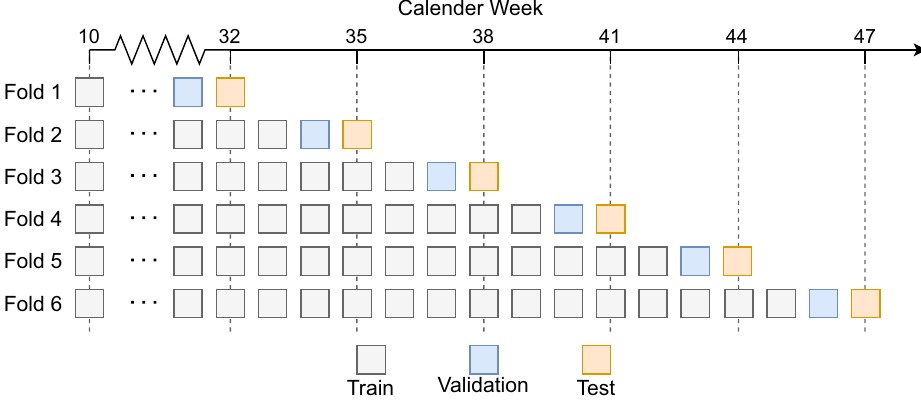
Figure 3. Evaluation Scheme based on an expanding window approach over the available historical weekly data